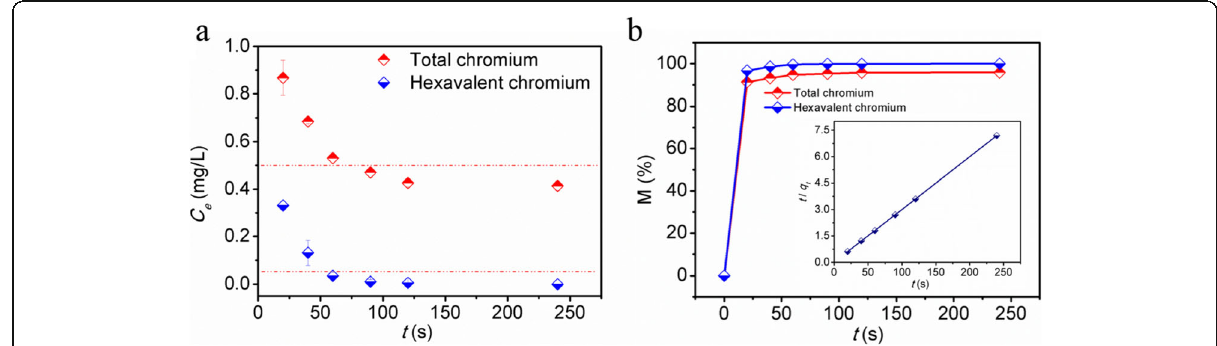
Fig. 4 a Cr(VI) and total chromium sorption kinetics of PPMs; b the adsorption curve of Cr(VI) and total chromium removal rate versus reaction time, inset shows the fitting data of the pseudo-second-order kinetic model of Cr(VI) adsorption. (Condition: PPMs 18 mg, K 2 Cr 2 O 7 solution with Cr(VI) concentration of 10 mg/L, 60 mL, pH =